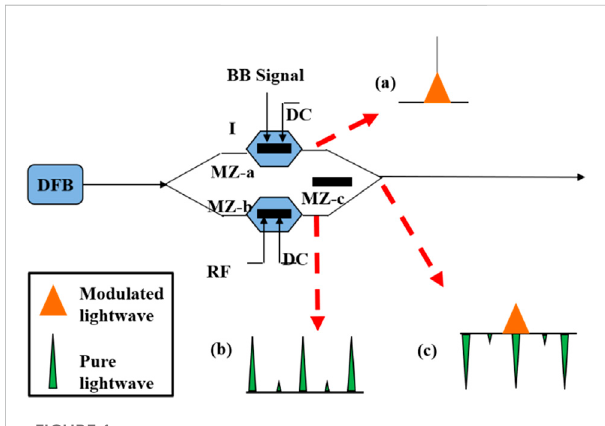
FIGURE 1 SchematicdiagramoftheRSSBsystem. (A) Modulatedlightwave; (B) Pure lightwave; (C) Combined